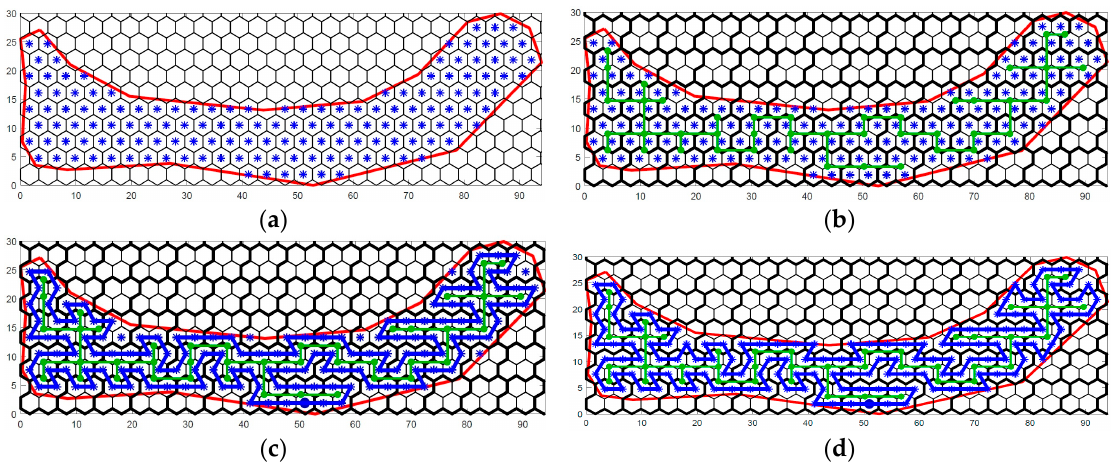
Figure 2. An execution example of the proposed hexagonal grid-based survey planner: ( a ) Hexagonal tessellation with Sampling Locations of Interest (SLoIs); ( b ) The created Minimum Spanning Tree (MST) vertices and the constructed relative MST; ( c ) Generation of the circumnavigation path based on the MST. The solid circle on the path denotes a selected starting point; ( d ) The overall path ring after path update.